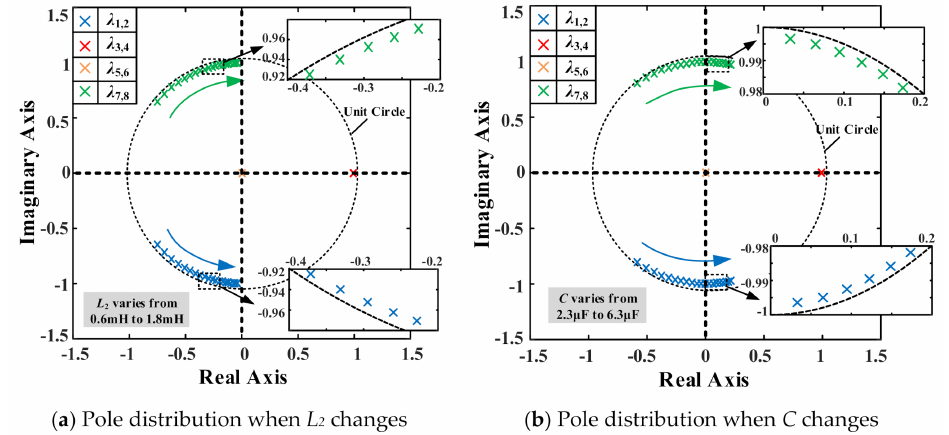
Figure 10. Variation trend for pole distribution of the DOB in case of parameter